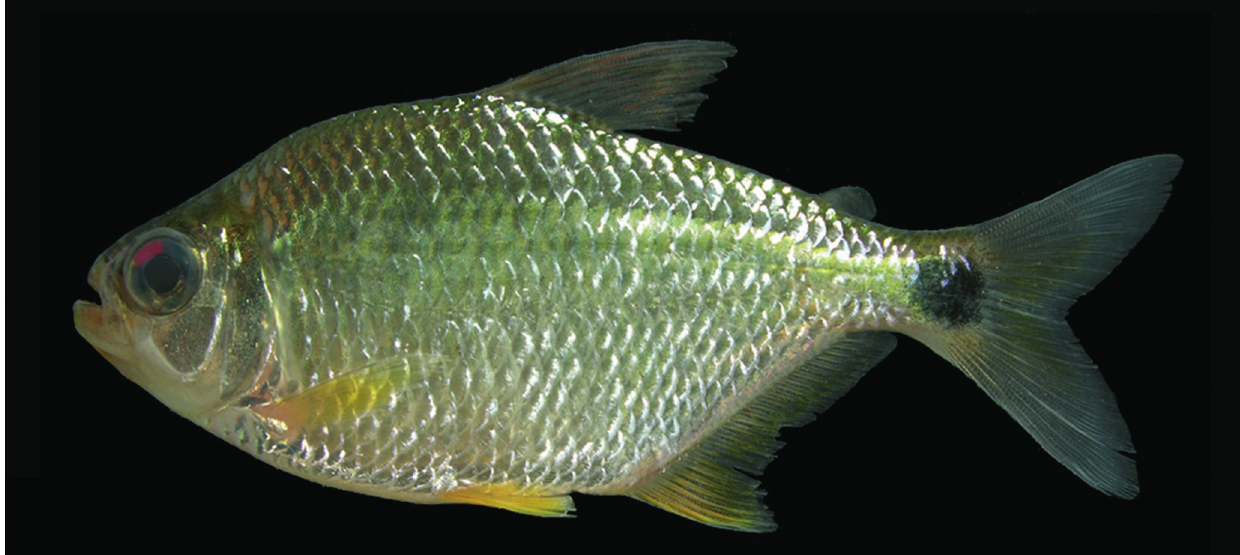
Fig. 5. Jupiaba cf. meunieri , live specimen, MZUSP 96817, 78.0 mm SL, Cachoeira da Neblina, rio Peixoto de Azevedo, tributary of rio Teles Pires, Tapajós basin. Photo by Mark Sabaj Pérez.